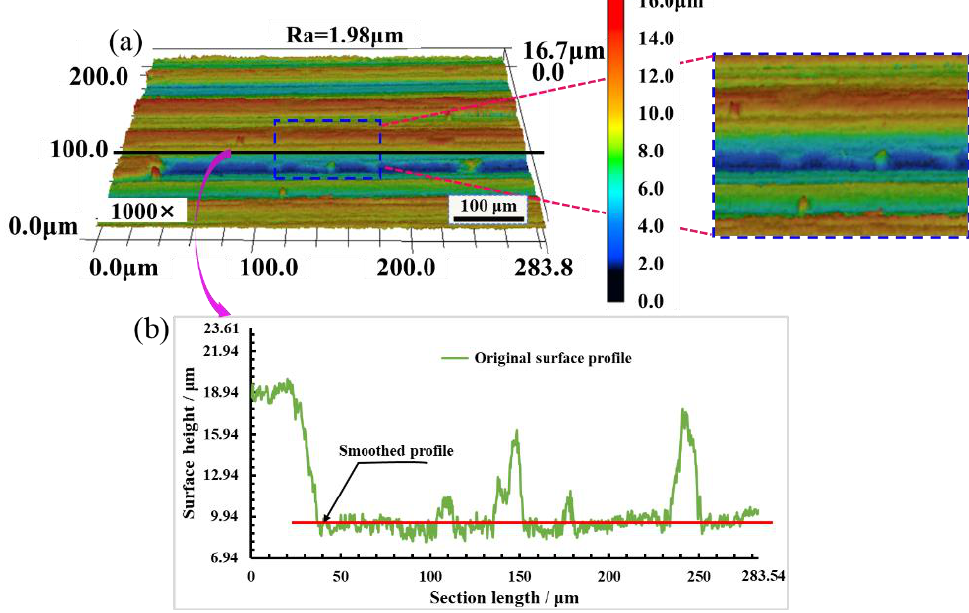
Figure 16. Morphology and profile of original surface. ( a ) Surface morphology; ( b ) Surface profile.